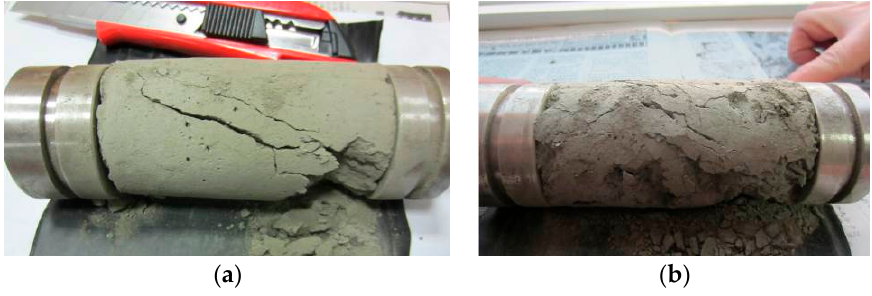
Figure 11. Specimen form after the failure of the mixed disposal with different waste rock contents. ( a ) Waste rock content of 10%; and ( b ) waste rock content of 50%.